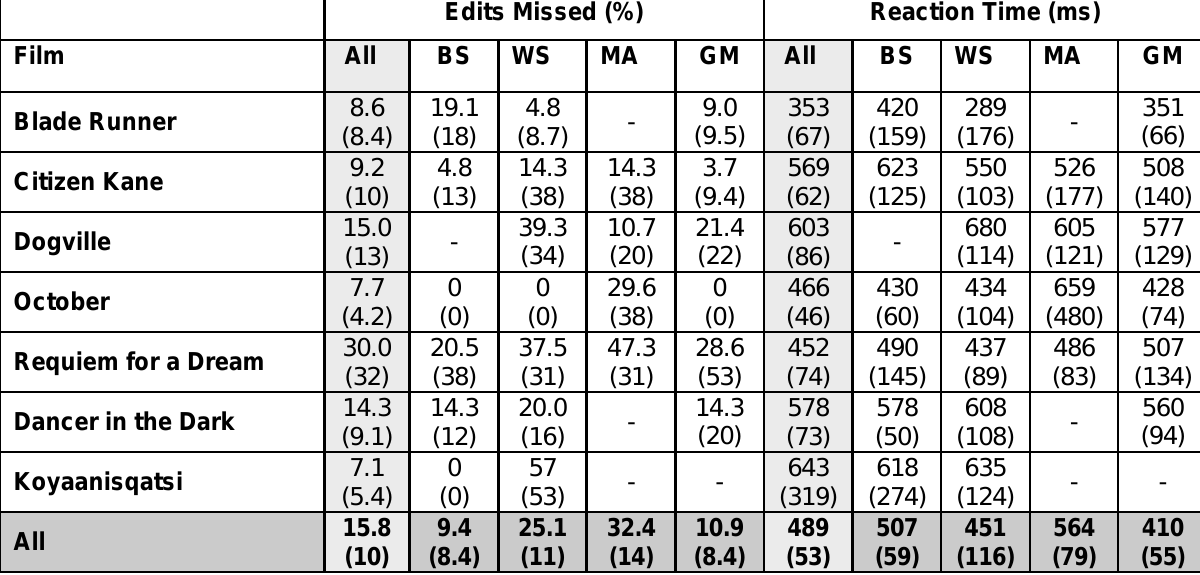
Table 2: Percentage of edits missed (%) and reaction times (ms) for detected edits. Results are split by film (rows), presented for all edits (vertical light grey, ‘All’ columns) and a subset of edits that are cuts with shot size CU, CMS, or MS and type Between Scene (BS), Within Scene (WS), Match Action (MA), and Gaze Match (GM). Means across all films are presented on the bottom row. Standard Deviations are presented in parantheses